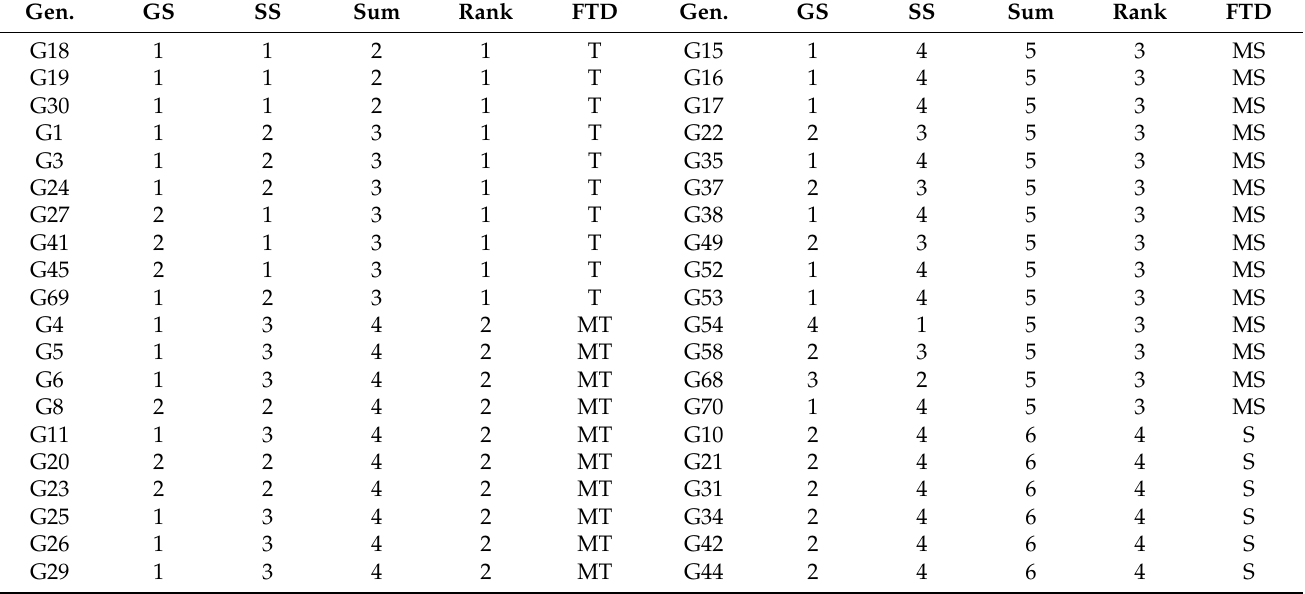
Table 8. Final ranking of genotypes (Gen.) for their relative salt tolerance at the germination stage (GS) and seedling stage (SS) based on the stress tolerance index of the traits of each stage in cluster analysis (Ward’s minimum variance